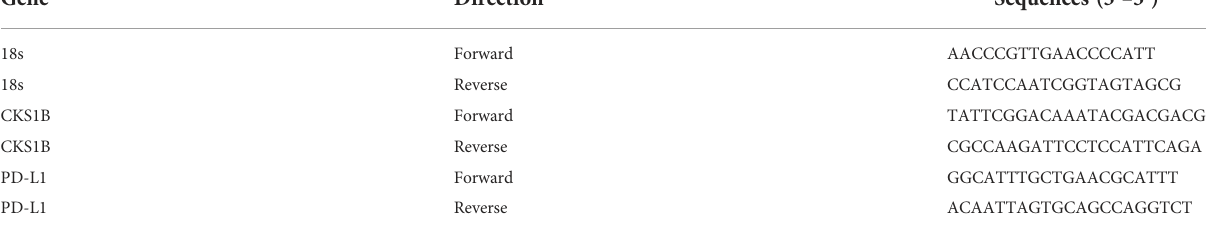
TABLE 1 Primers used for qRT ‐ PCR